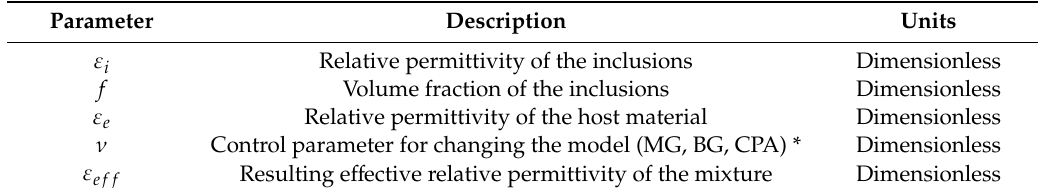
Table 1. Description of the parameters in the e ff ective medium theory model (Equation (7)) Parameter Description Units ε i Relative permittivity of the inclusions Dimensionless f Volume fraction of the inclusions Dimensionless ε e Relative permittivity of the host material Dimensionless ν Control parameter for changing the model (MG, BG, CPA) * Dimensionless ε ff ective relative permittivity of the mixture ef f Resulting e